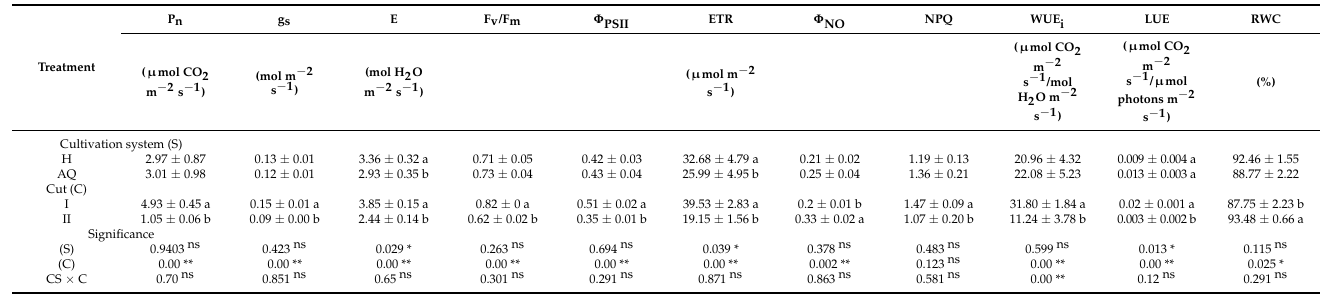
Table 2. Gas exchanges and chlorophyll fluorescence emission in terms of leaf net photosynthesis (P n ), stomatal conductance (g s ), leaf net transpiration (E), maximal photochemical efficiency of PSII (F v /F m ), yield of PSII ( Φ PSII ), linear electron transport rate (ETR), yield of non-regulated quenching ( Φ NO ), non-photochemical quenching (NPQ), intrinsic water use efficiency (WUEi), light use effi- ciency (LUE), and relative water content (RWC) in Genovese basil cv. Sanremo plants under two consecutive cuts (35 (I) and at 79 (II) days after planting (DAP)) grown under hydroponic (H) or aquaponics (AQ)